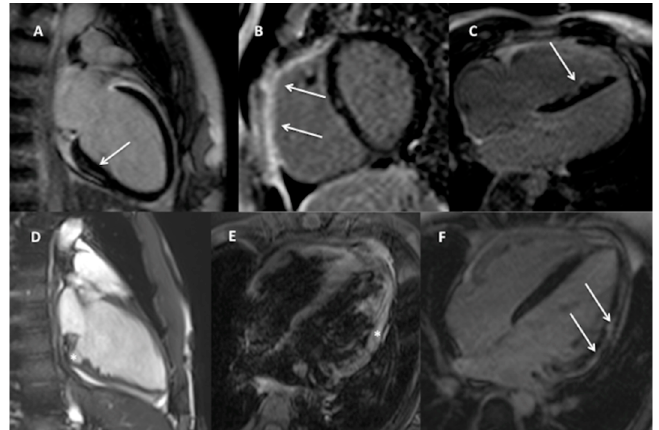
Figure 3. Examples of potentially arrhythmogenic CMR findings in the studied cohort: ( A ). Two-chamber view, non-ischemic, subepicardial area of fibrosis in the basal infero-septal segment of the LV (arrow) without signs of myocardial oedema (not shown) in a 16-year-old girl with 12%/24 h of complex LBBB-like PVCs suggestive of previous myocarditis; Band ( C )—regions of LGE (arrows) in the RV outflow tract and free wall (( B )—short-axis view) and in the interventricular septum ( C )—4-chamber view) in a 17-year old boy with <1%/24 h complex LBBB-like PVCs and an overall small MRI criteria for ARVC. ( D ). Two-chamber cine view in end-diastole showing large crypt (asterisk) and irregular myocardial pattern of the inferior LV wall in a 13-year-old boy with 14%/24 h of RBBB-like PVCs, ( E , F ). 4-chamber view, signs of myocardial oedema (E—asterisk) and subepicardial, non-ischemic stria of fibrosis (F—arrows) in the lateral LV wall in a 14-year-old boy with <1%/24 h of complex undetermined PVCs indicative of acute myocarditis.